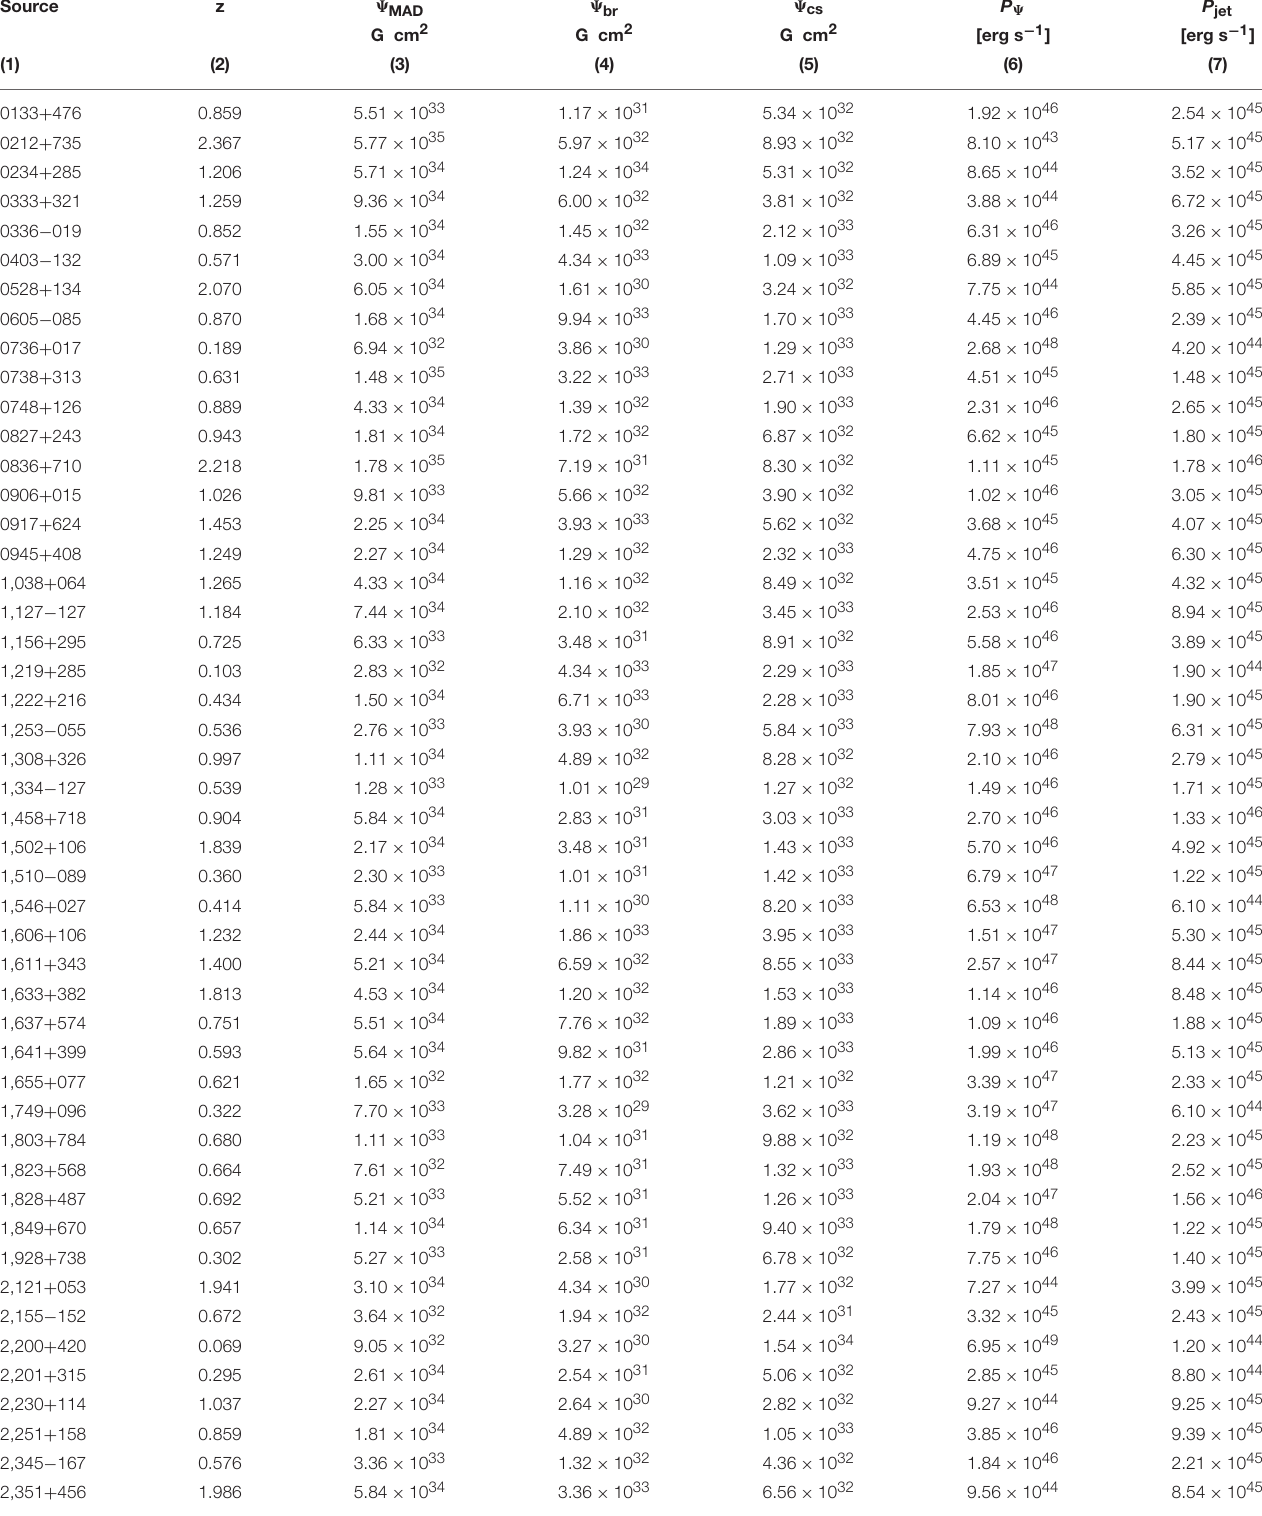
TABLE 1 | Jet important observed and derived